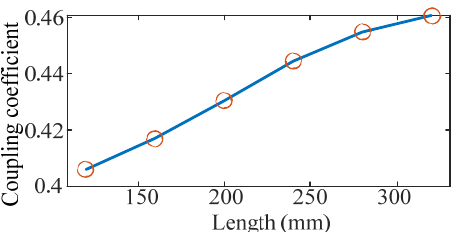
Figure 9. Coupling coefficient waveform with different lengths.